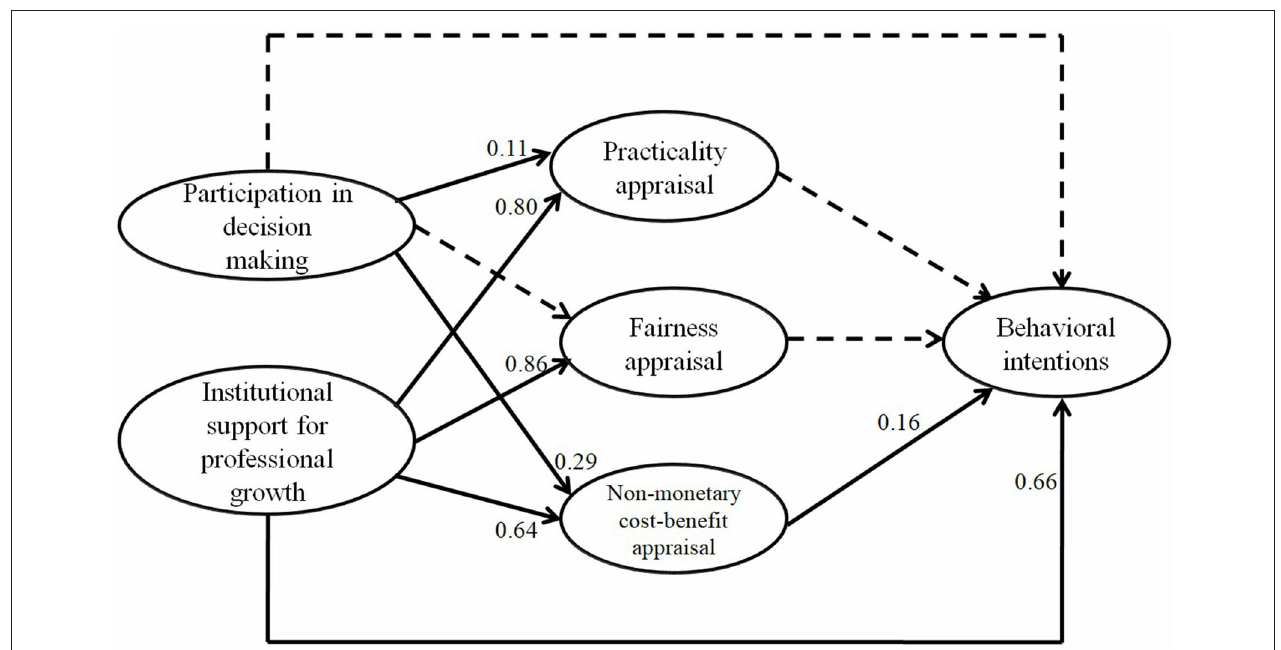
FIGURE 5 | The direct effect of participation in decision-making and institutional support for professional growth on appraisal and behavioral intentions ( N = 340). The 32 professors’ responses are taken